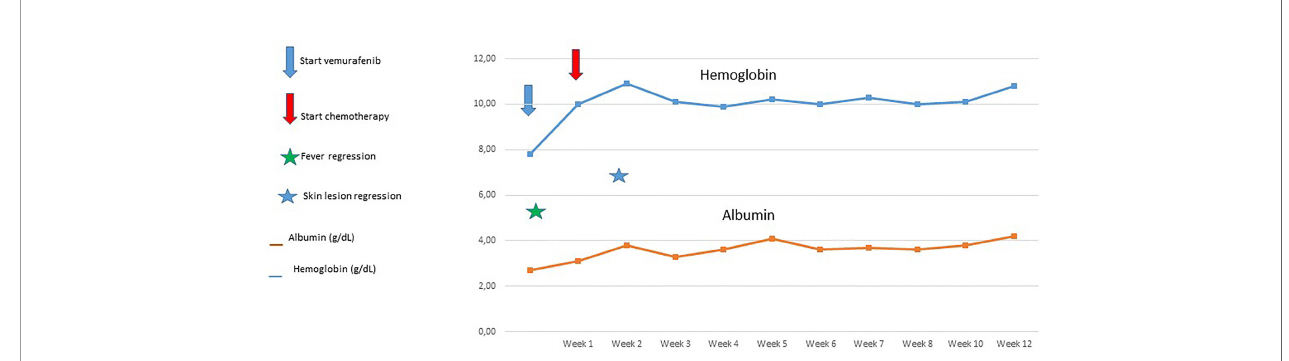
FIGURE 2 | Clinical and laboratory response to the combination of Vemurafenib with